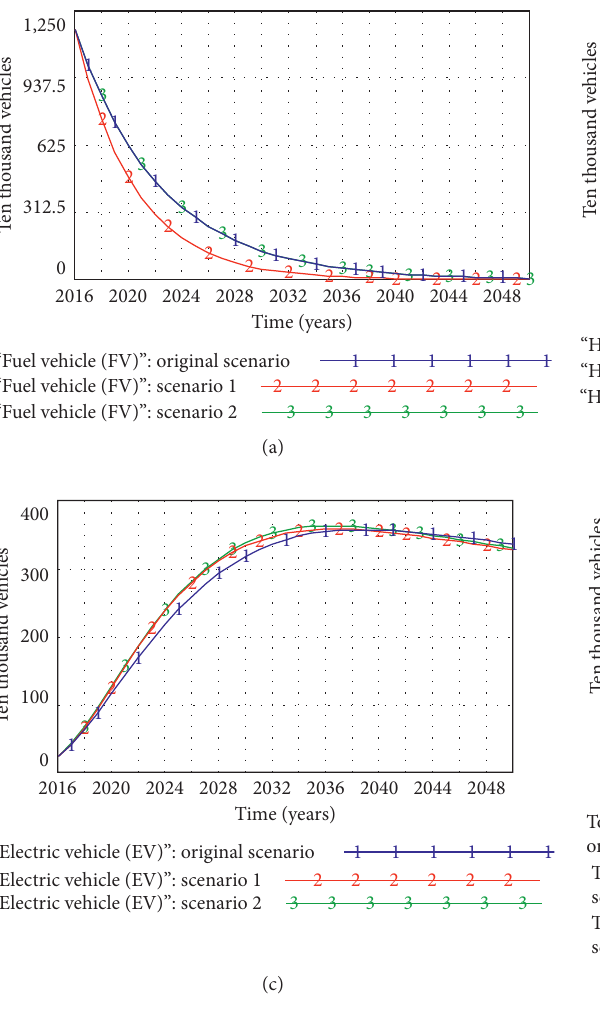
Figure 5: The changing trend of vehicles and total energy consumption under three scenarios. (a) FV. (b) HV. (c) EV. (d) Total energy